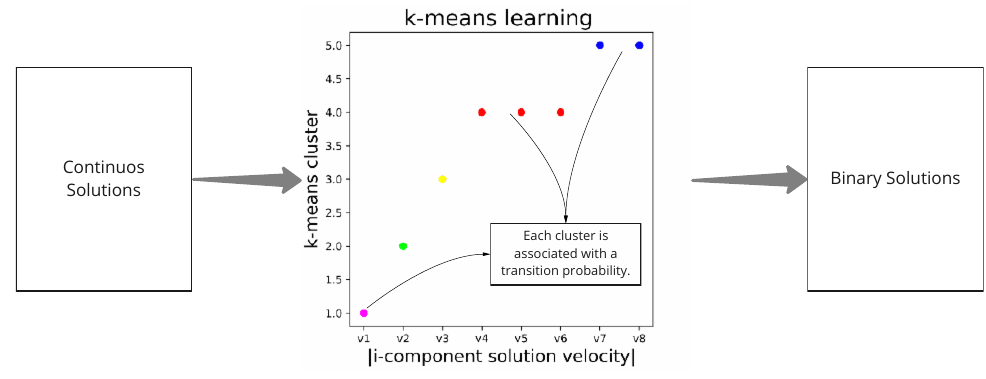
Figure 2. K-means binarization procedure. Algorithm 2 Machine learning binarization operator